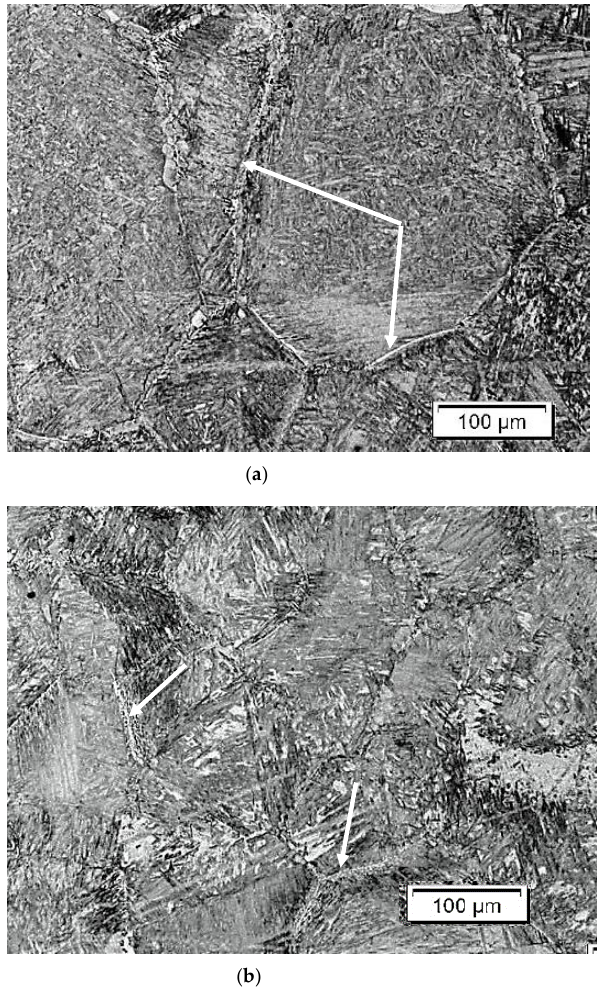
Figure 6. Quenched microstructures from a T U of ( a ) 758 °C and ( b ) 958 °C before deformation, showing the presence of thin ferrite films on PAGBs (arrows).